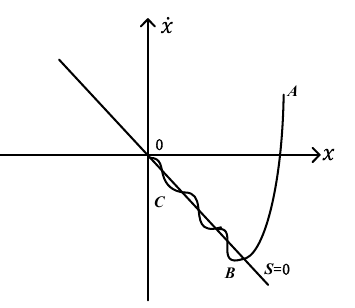
Figure 1. State trajectory of the sliding mode control (SMC) system.